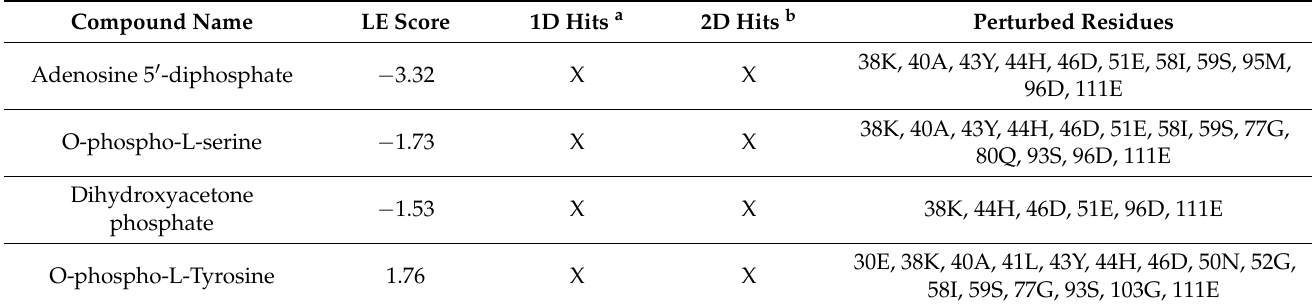
Table 3. Phosphorous compounds that bind DNAJA1-107.